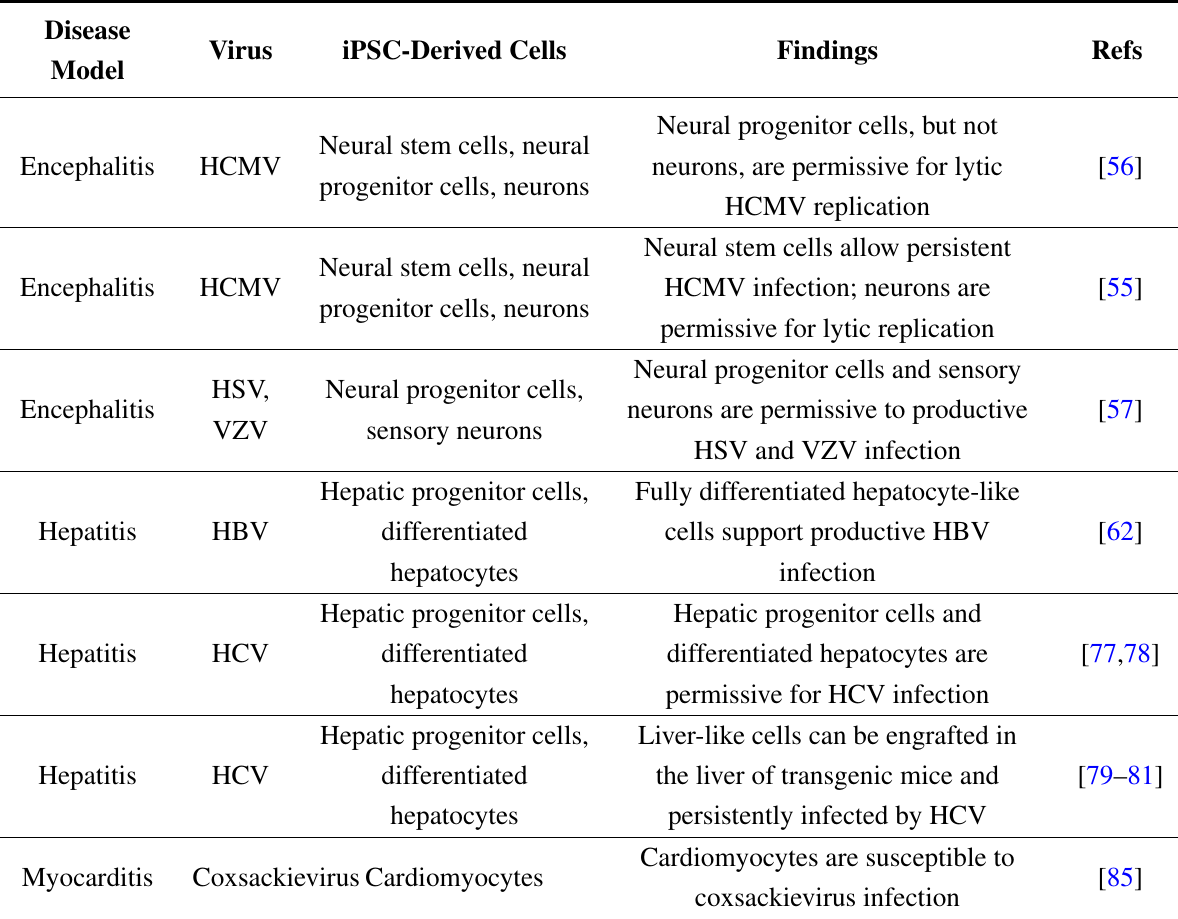
Table 1. Human induced pluripotent stem cell (iPSC)-derived models of viral